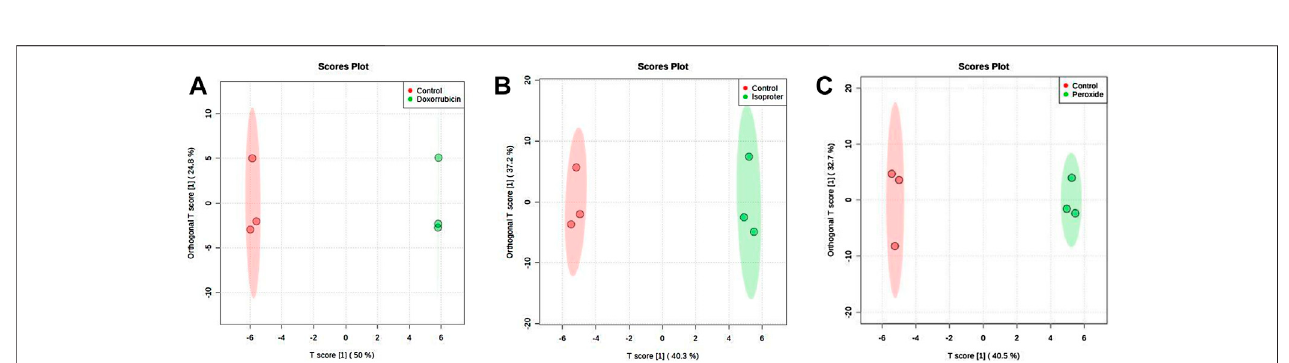
FIGURE4| OPLS-DAscoreplotofallmolecularfeatures. (A) DOXversusControl, (B) ISOversusControland (C) PERversusControlofthecellextractanalyzedby CE-(ESI)-MS, in positive ionization mode.